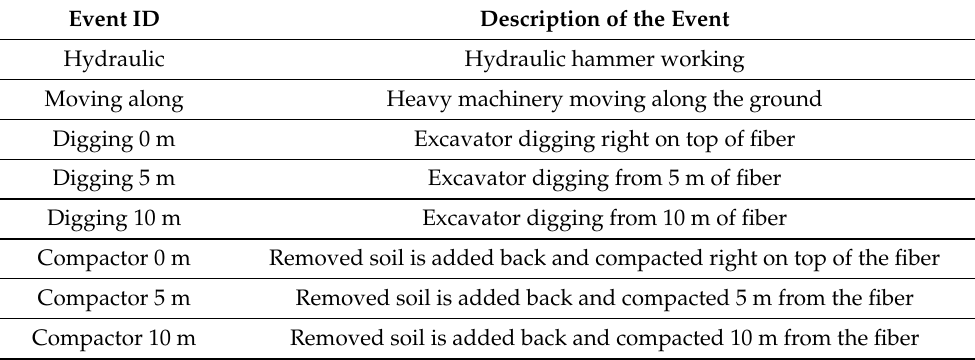
Table 1. Events performed that form the test